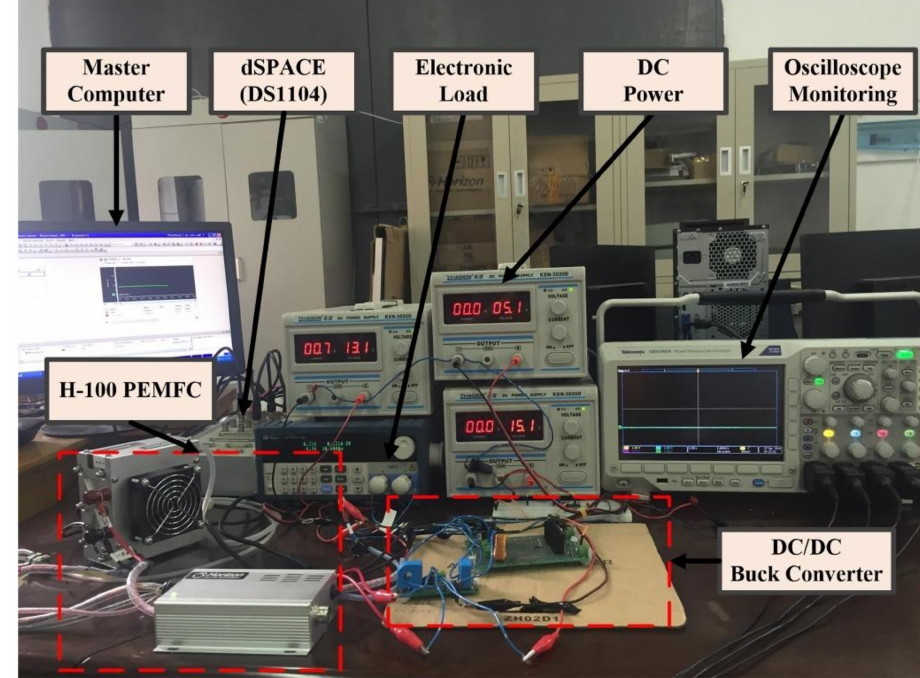
Figure 9. Experimental test for the power supply prototype.